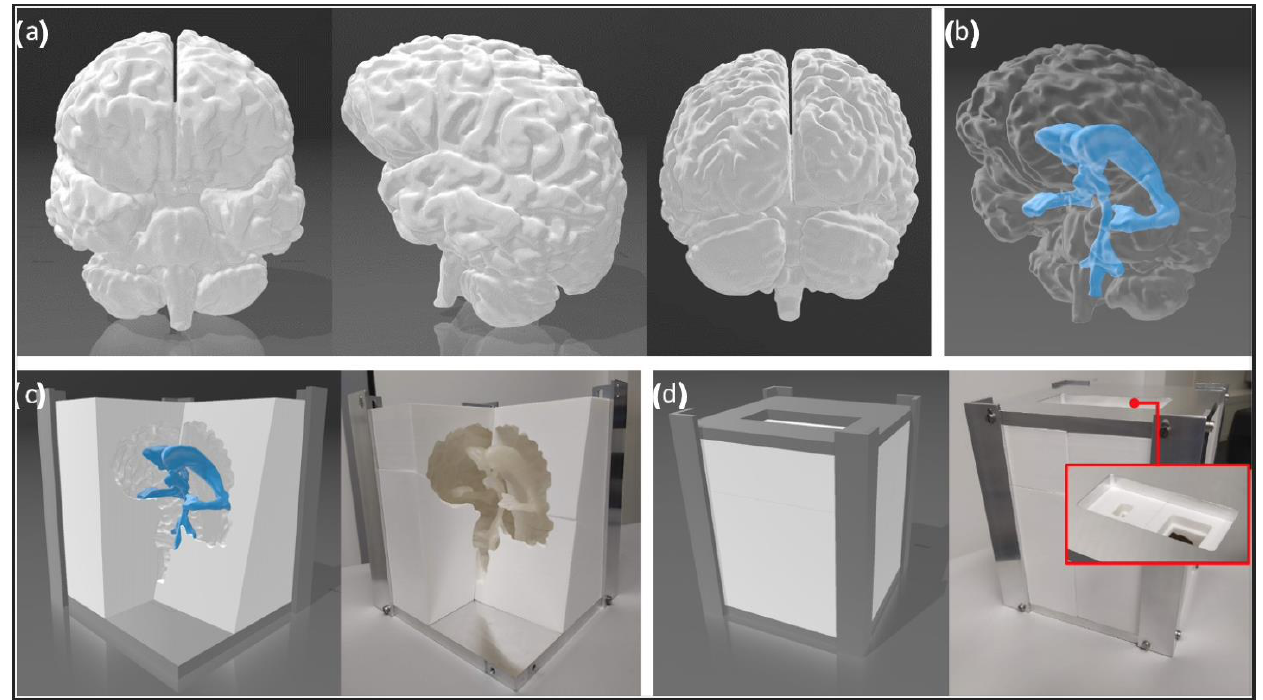
Figure 3. ( a ) Computational model of the brain, segmented from the MR image. ( b ) Computational model of the ventricles, located inside the brain. ( c ) Inside view of the computational model of the brain mold and corresponding inside view of the 3D-printed brain mold. ( d ) Outside view of the computational model of the brain mold and corresponding outside of the 3D-printed brain mold. The red frame shows the large and small openings at the top.